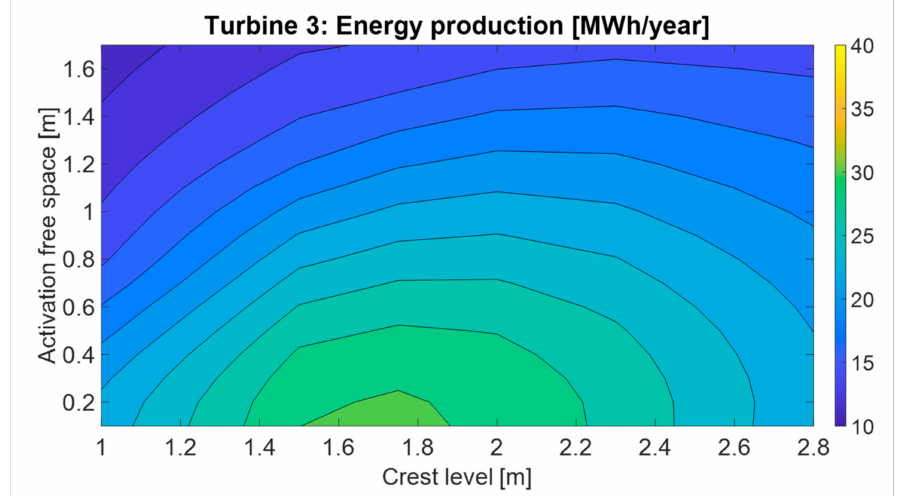
Figure 9. Energy produced by Turbine 3 as a function of the activation free space f a and the crest level h cr .